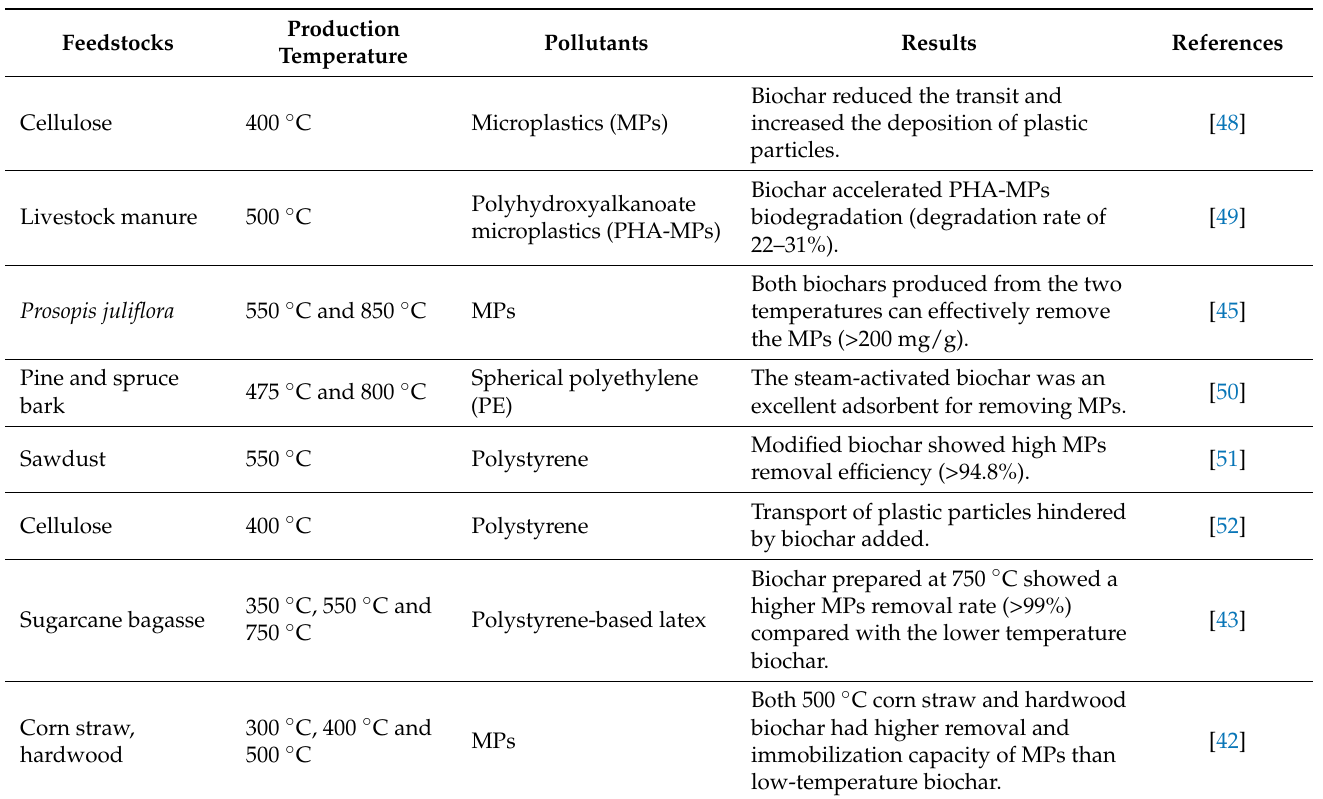
Table 2. Representative research on biochar’s ability to remove microplastics from aquatic environ-